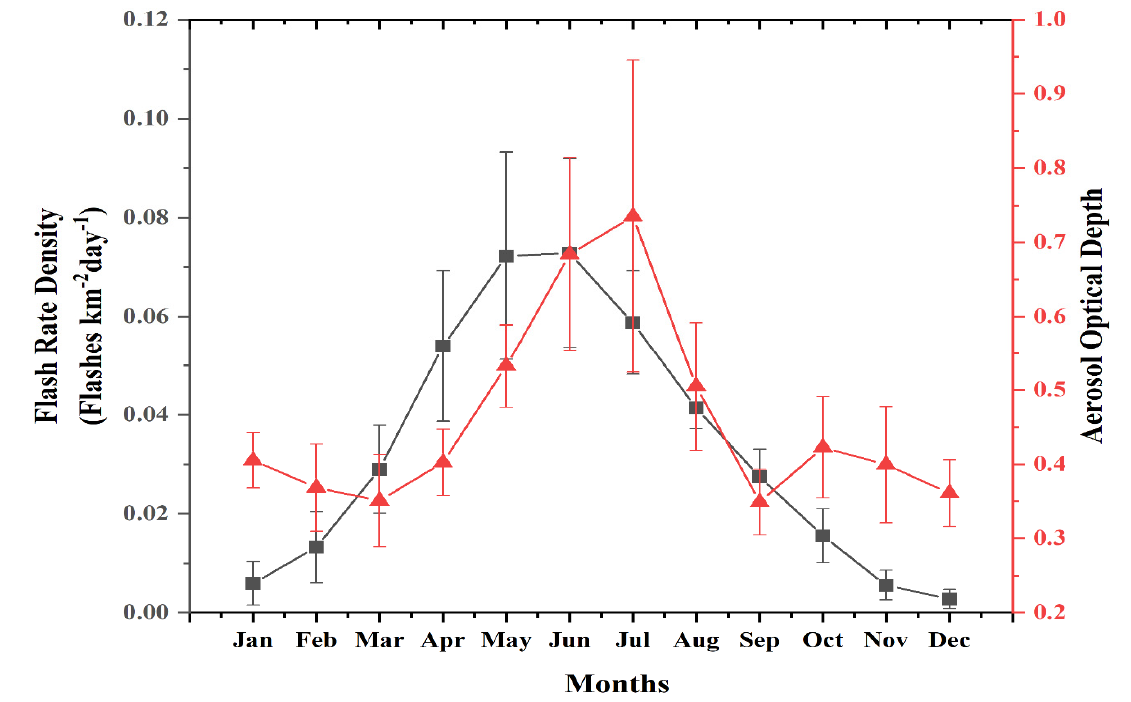
Figure 11. Monthly climatology for averaged values of the lightning flash rate density (on the primary Y -axis) with AOD (on the secondary Y -axis) for the period of 2000–2013 over the study region.